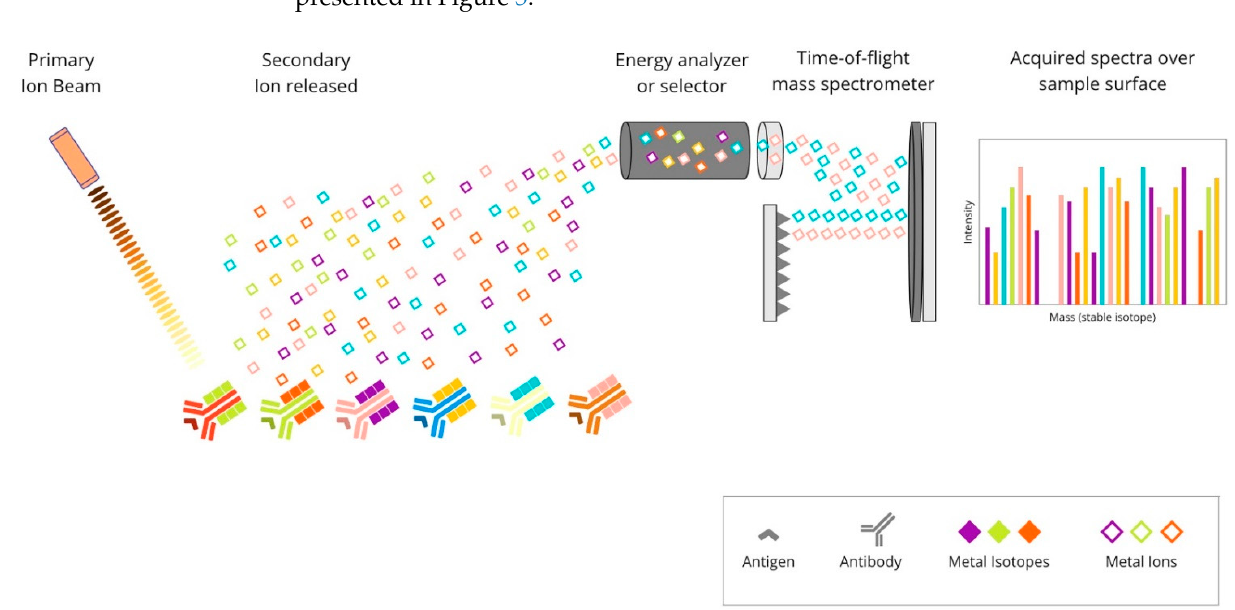
Figure 5. Overview of multiplexed ion-beam imaging technique: Mixture of antibodies are labelled with isotopically pure metal-chelator tags. Each antibody binds to a single protein target. Then, a thin layer of the sample surface is ablated using an oxygen-based primary ion beam. Metal isotopes are released from antibodies as secondary ions, which are then transported to a time-of-flight mass spectrometer. Each unique metal ion represents a